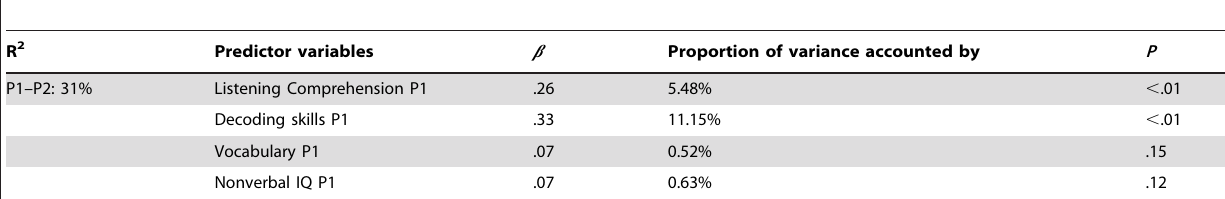
Table 3. Standard multiple regression analyses with the reading comprehension of utterances as dependent variable and variables of interest at P1 as predictors (for decoding skills: accuracy scores for word and pseudoword reading).